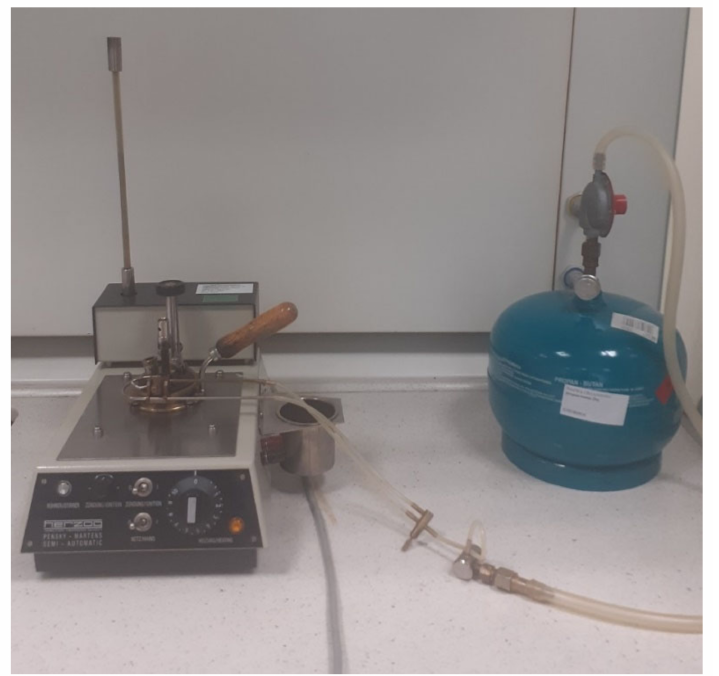
Figure 1. Flash Point Pensky–Martens Semi-Automatic camera from Walter Herzog GmbH used in the study (photograph by M.